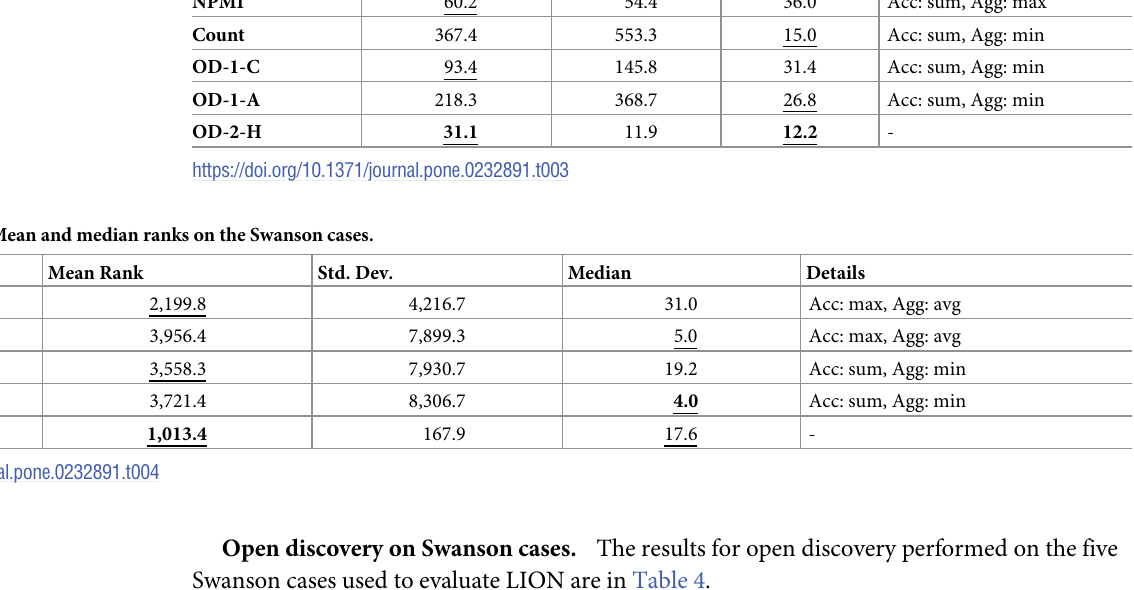
Table 3. Open discovery: Mean and median ranks on the cancer discovery cases. Approach